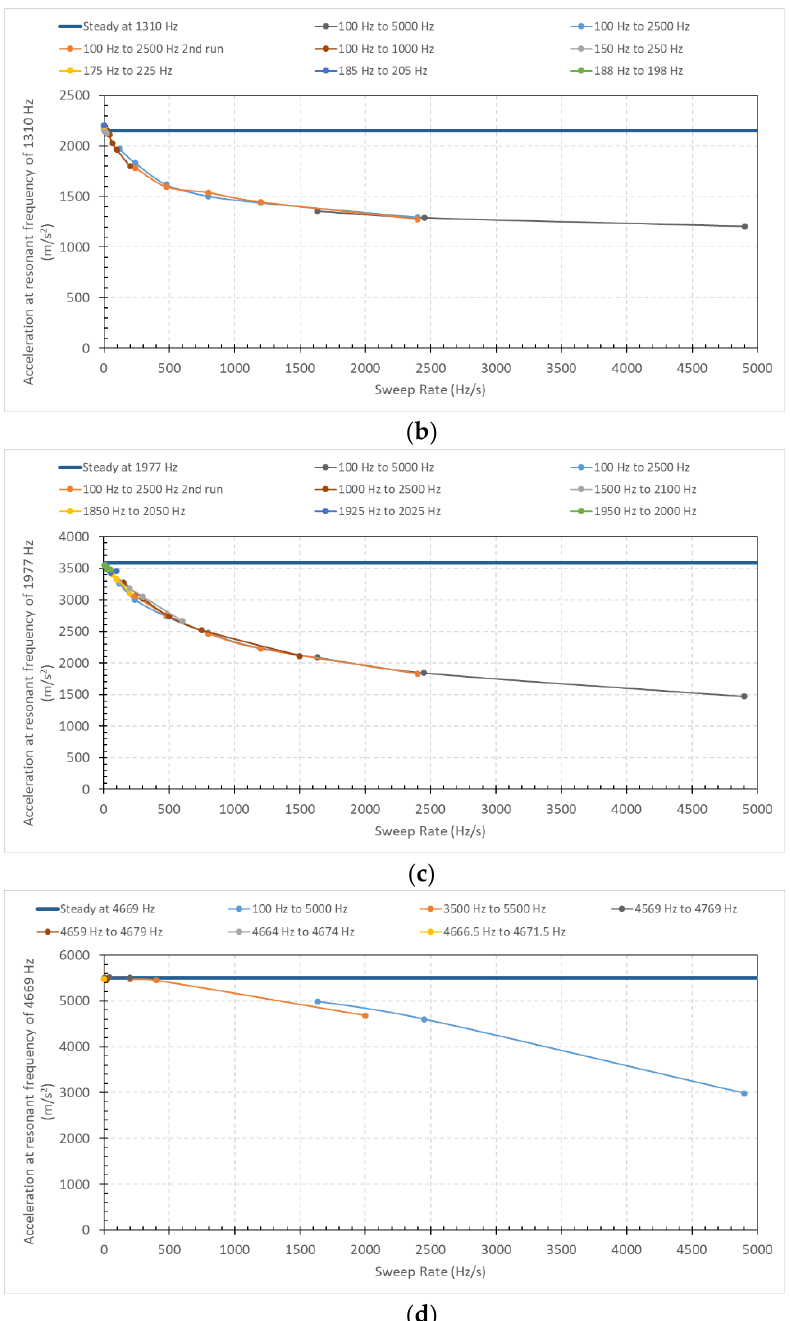
Figure 4. Maximum acceleration on plate edge for frequency sweeps at different frequency ranges in function of the sweep rate at 200 Vpp with the piezoelectric actuator 5 at 192 Hz ( a ), 1310 Hz ( b ), 1977 Hz ( c ) and 4669 Hz ( d